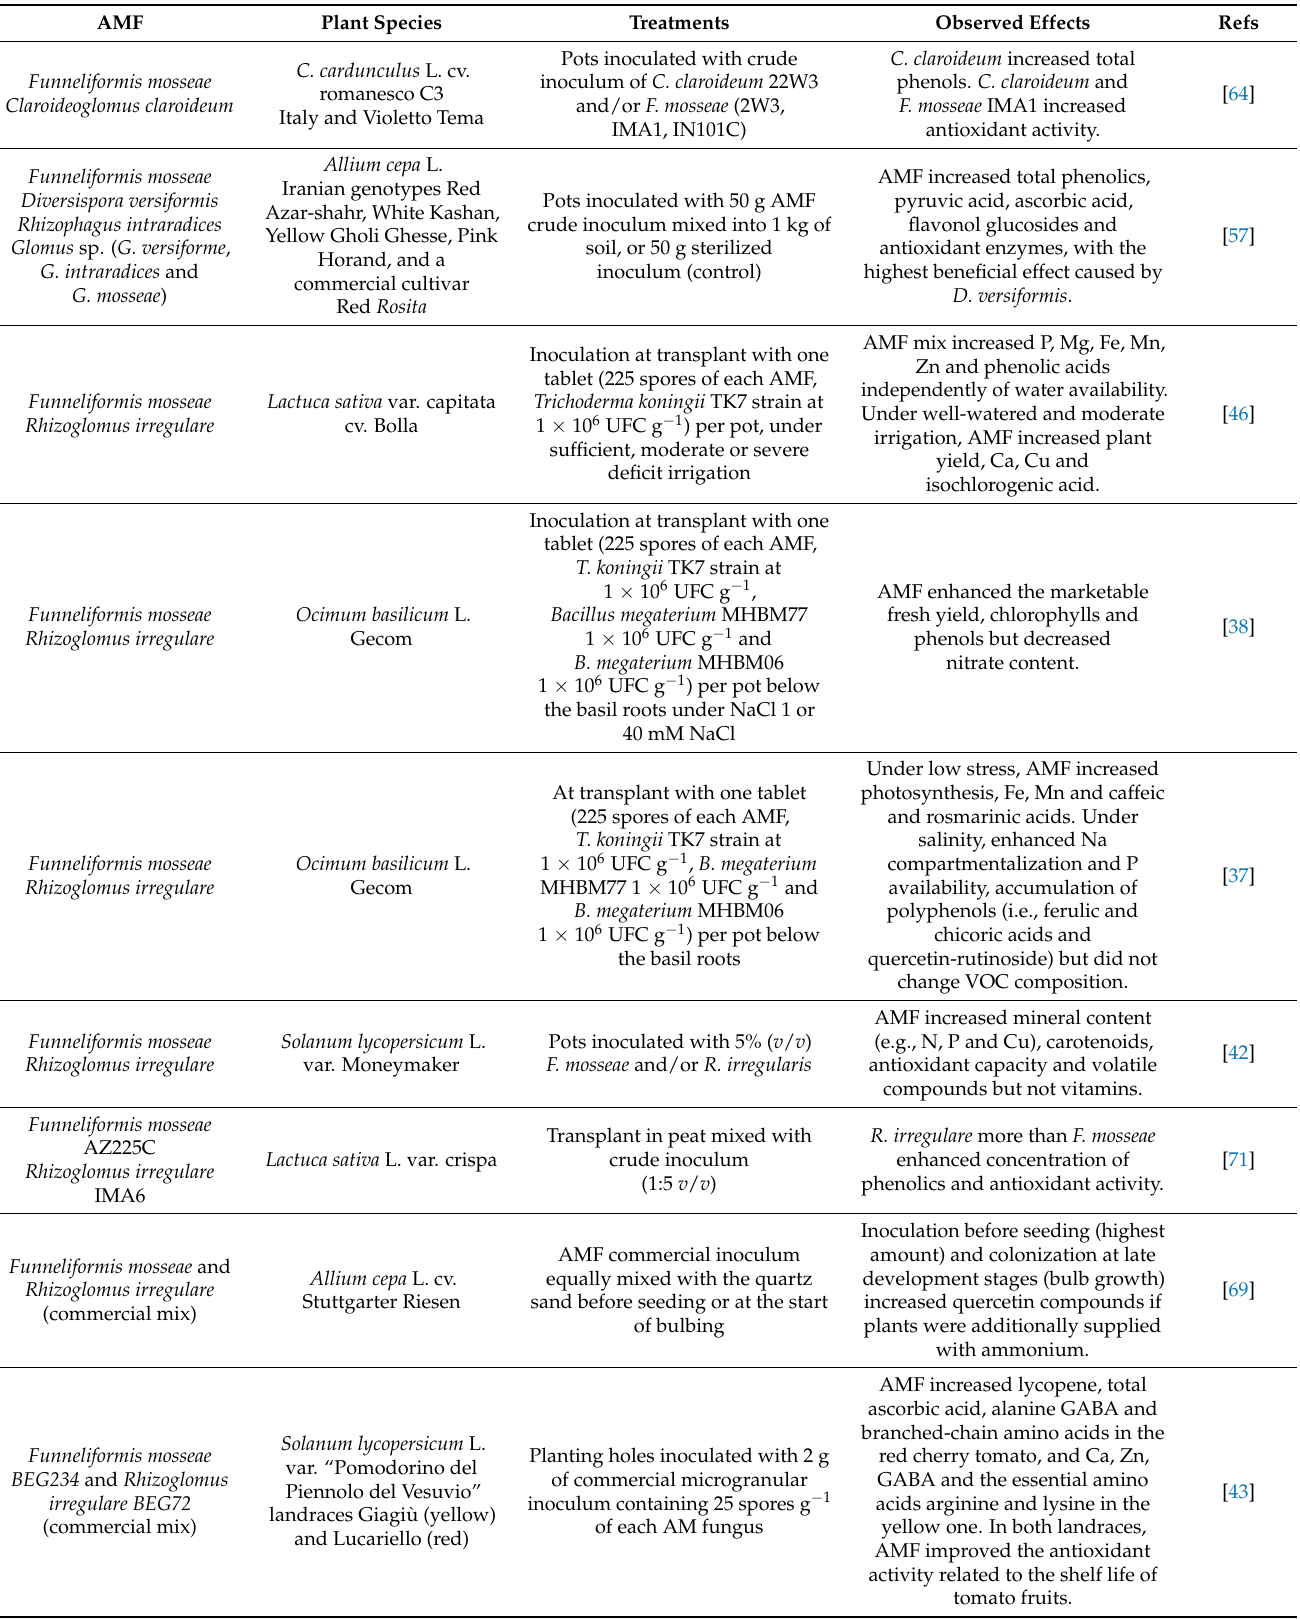
Table 2. Vegetable crops’ treatment with AMF-based biostimulants and observed